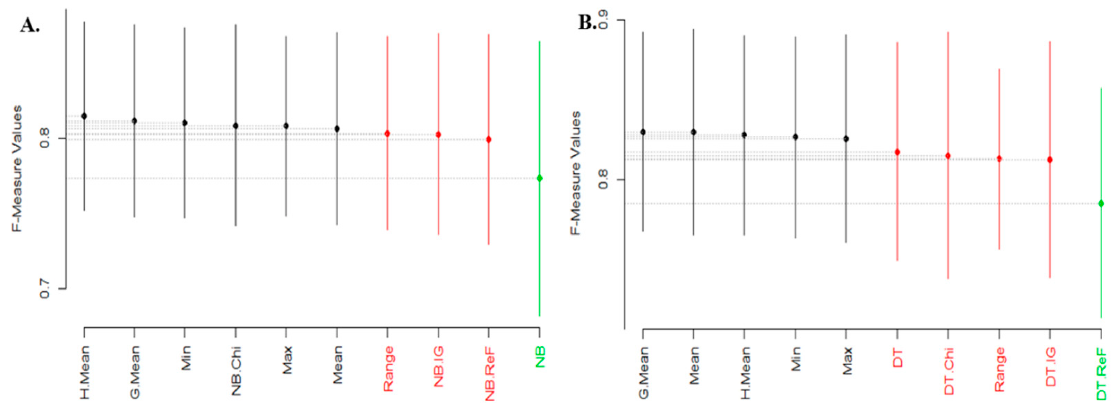
Figure 7. Scott-Knott Rank Test Result of FS methods on NB and DT classifier models based on average F-measure values. ( A ) Average F-Measure values of NB; ( B ) Average F-Measure values of DT. Table 6. Summary of the Scott-Knott Rank Test of experimented FS methods on NB and DT models.